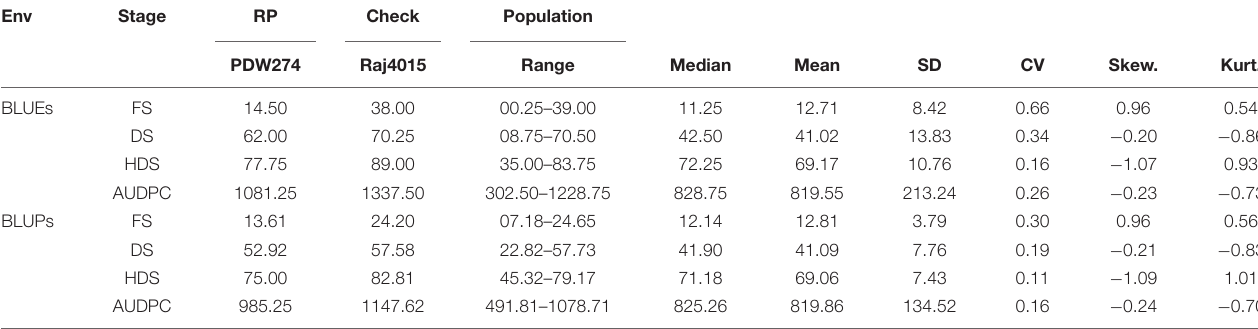
Env Stage RP Check Population PDW274 Raj4015